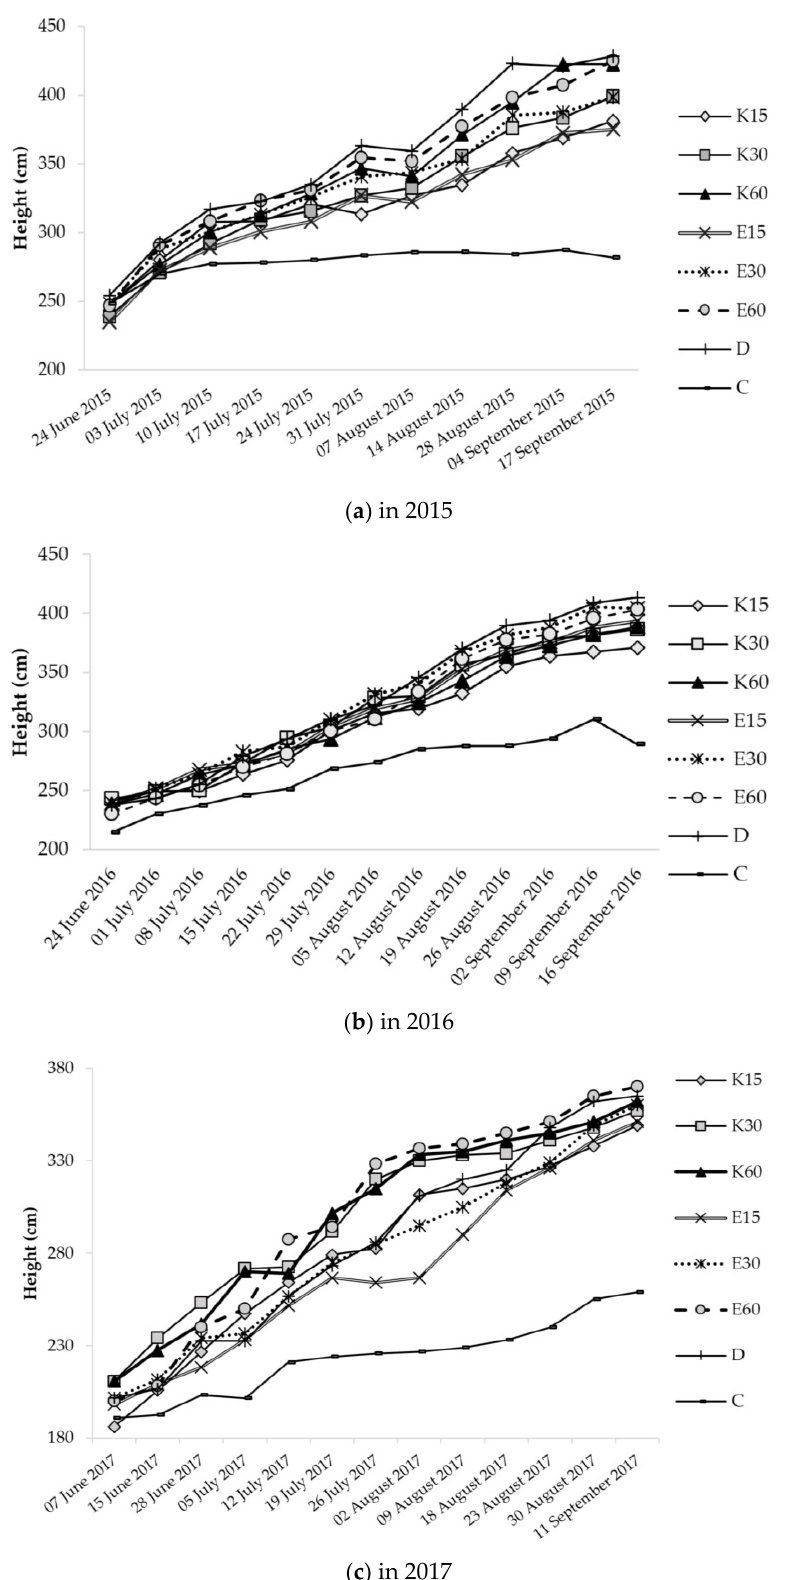
Figure 2. Plant height values from 2015 to 2017 growing years: ( a ) height values of S. alba energy willow coppice in a year of 2015; ( b ) height values of S. alba energy willow coppice in a year of 2016; ( c ) height values of S. alba energy willow coppice in a year of